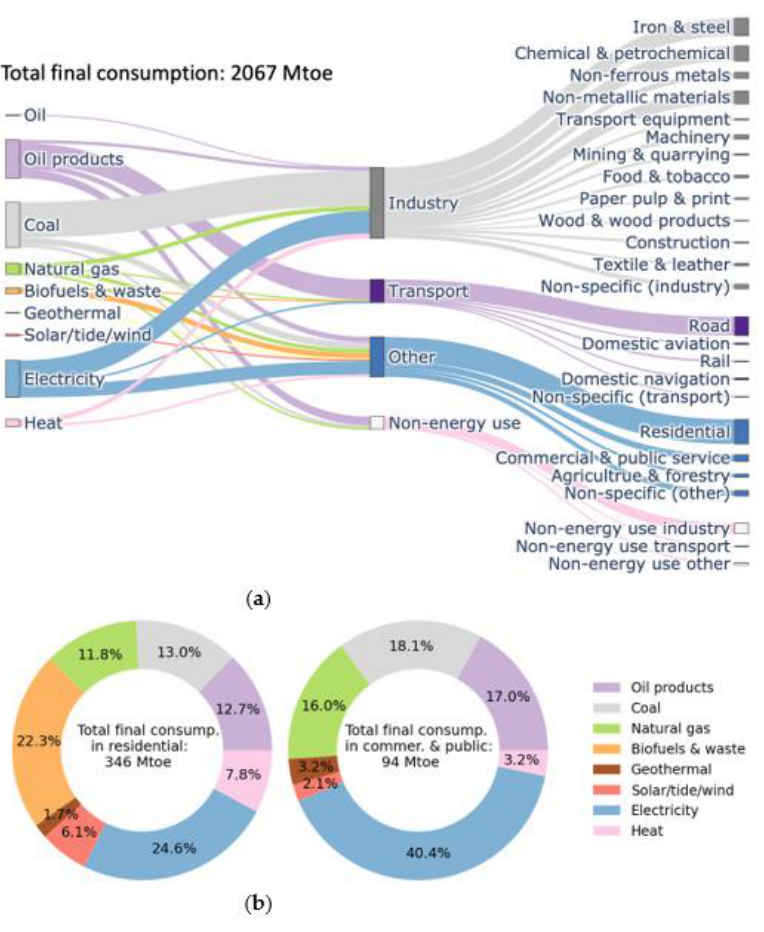
Figure 2. ( a ) China total energy consumption flow; ( b ) China total final energy consumption in residential, commercial, and public buildings (data compiled from [13]).